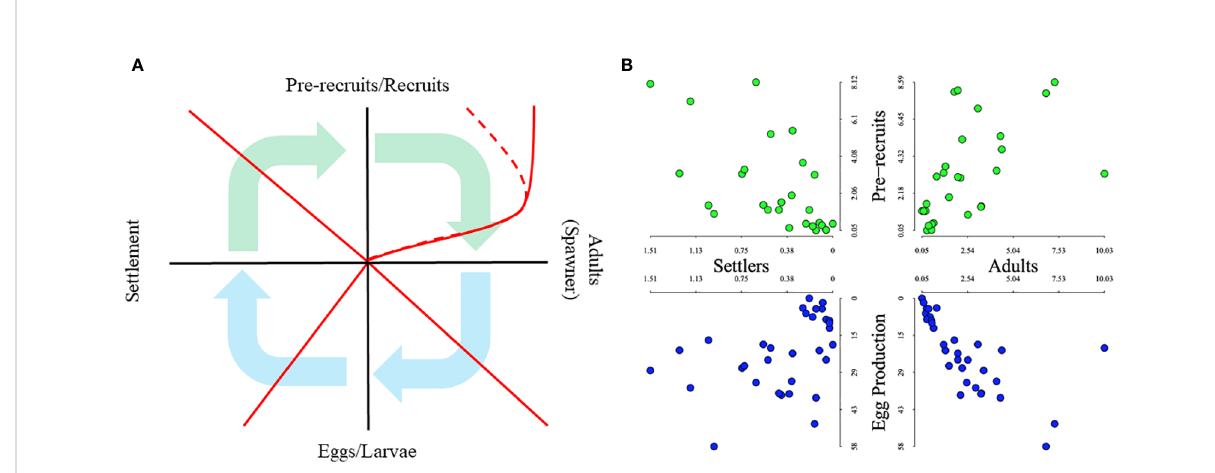
FIGURE 4 (A) Theoretical American lobster Paulik diagram adapted from Wahle (2004) between adult (spawners), pelagic stage (eggs/larvae), young-of- year (settlement) and pre-recruit or recruit lobsters. Arrows indicate the fl ow of life stages through the diagram for pre-settlement (blue) and post-settlement (green) stages. Red lines represent theoretical relationships between life stages. The solid and dashed lines for the upper right sub panel represent Beverton-Holt and Ricker stock-recruit functions. (B) Application of the Paulik diagram for American lobsters in southern New England (United States) with data from Rhode Island. Points represent relative abundance estimates by life stage and are colored by pre- settlement (blue) and post-settlement (green) stages. Details on data and methods can be found in Supplement